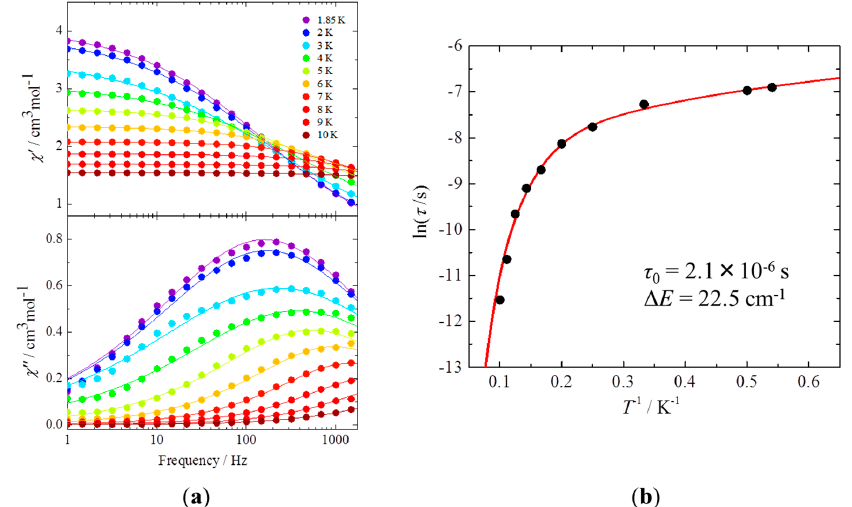
Figure 4. ( a ) Frequency dependence of χ′ and χ′′ for 1 in an H DC of 3000 Oe. The measurements were performed in H AC of 3 Oe and T range of 10–1.85 K; ( b ) Arrhenius plot for 1 using the τ values obtained from AC magnetic susceptibility measurements at several T . The red line is a fit made by using Equation (1) with parameters A = 5.3 × 10 2 s –1 K –1 and B = 3.6 × 10 –5 s –1